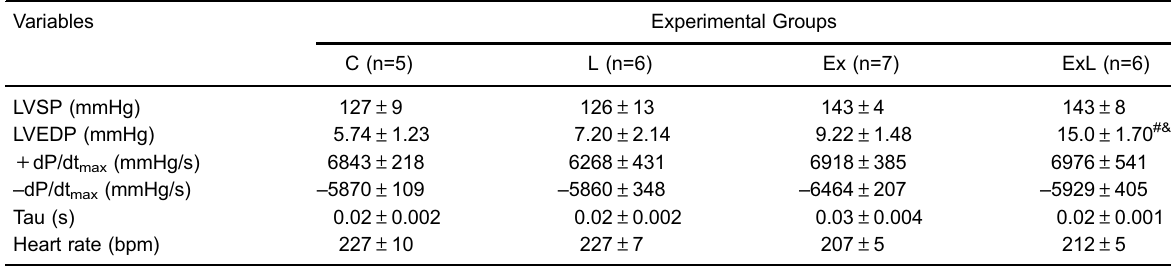
Table 2. Hemodynamics